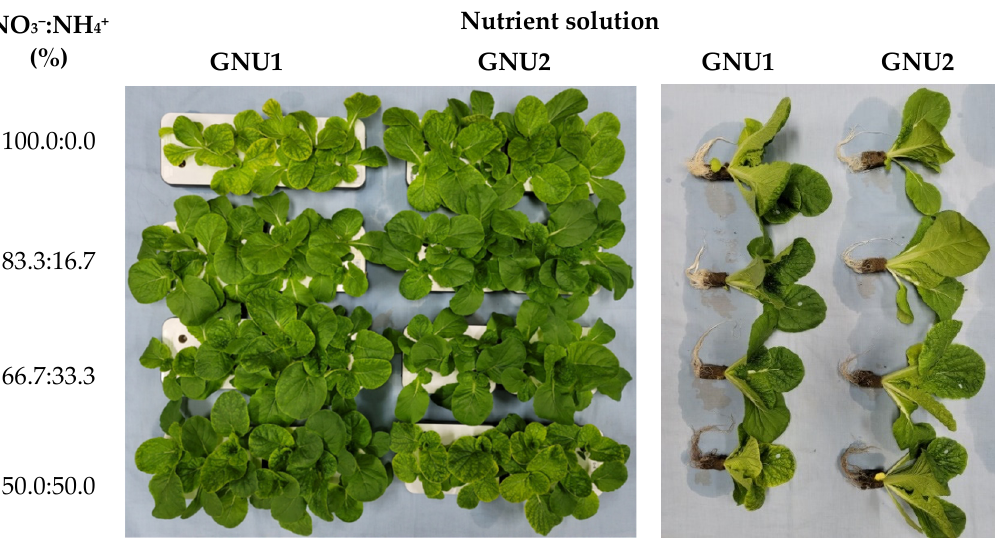
Figure 7. Growth of Ssamchoo as affected by the nutrient solution 28 days after sowing in Experi- ment 2. Eight treatment solutions were GNU1 and GNU2 in combination with four levels of NO 3 − /NH 4+ ratio (100:0, 83.3:16.7, 66.7:33.3, and 50:50), and they were classified into subgroups as 1, 2, 3, and 4, respectively.